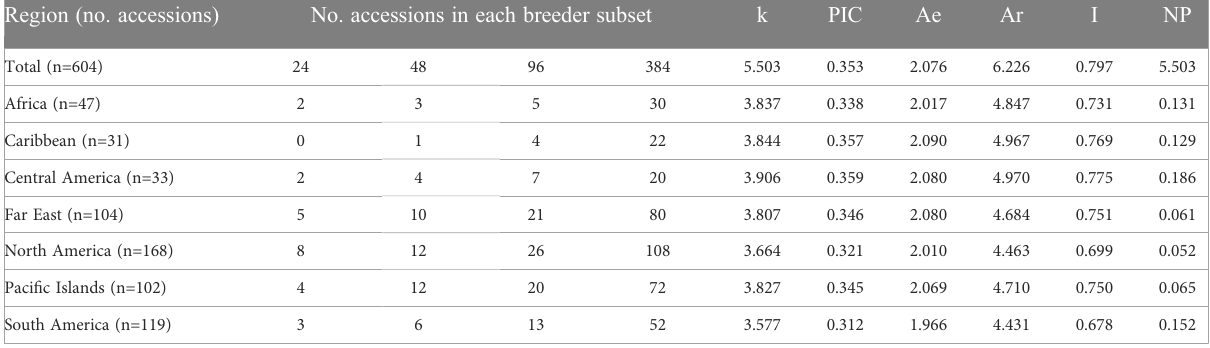
TABLE 1 Collection location, breeder subset membership, and genetic diversity indices of 604 sweetpotato ( Ipomoea batatas ) accessions. Region (no.